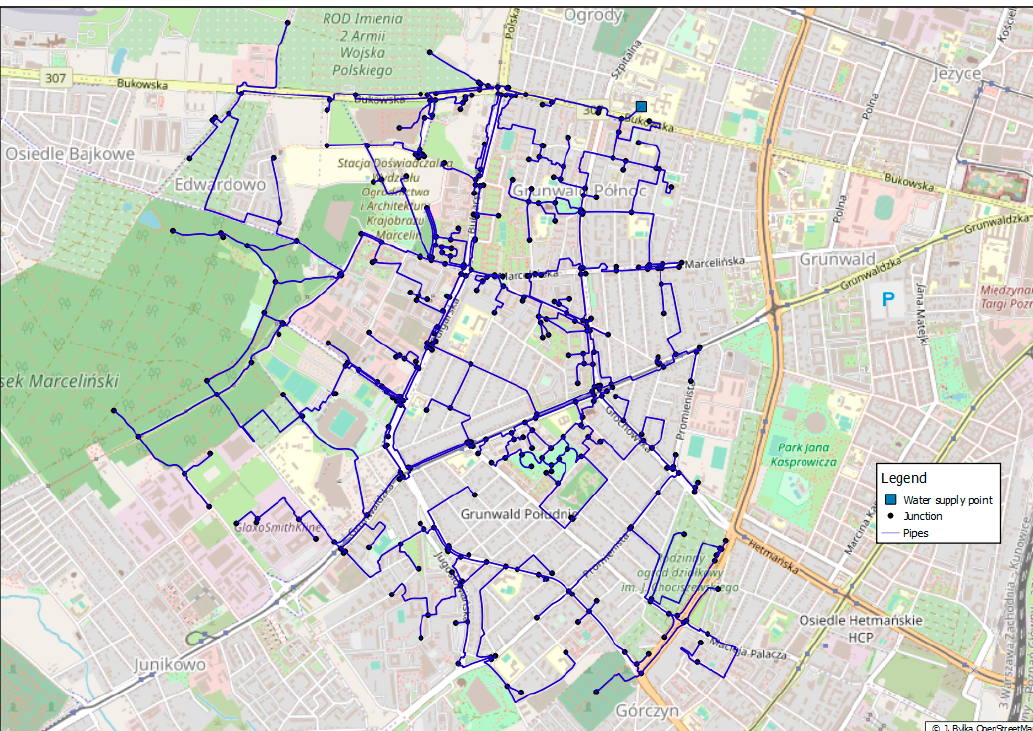
Figure 9. Analysed water supply system.